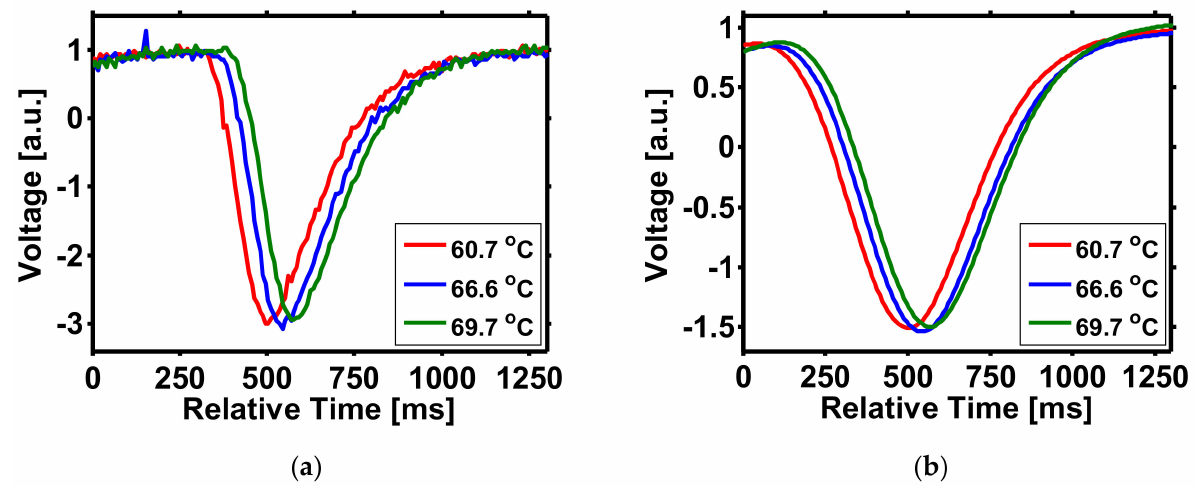
Figure 9. Three of the received curves ( a ) before and ( b ) after the filter.